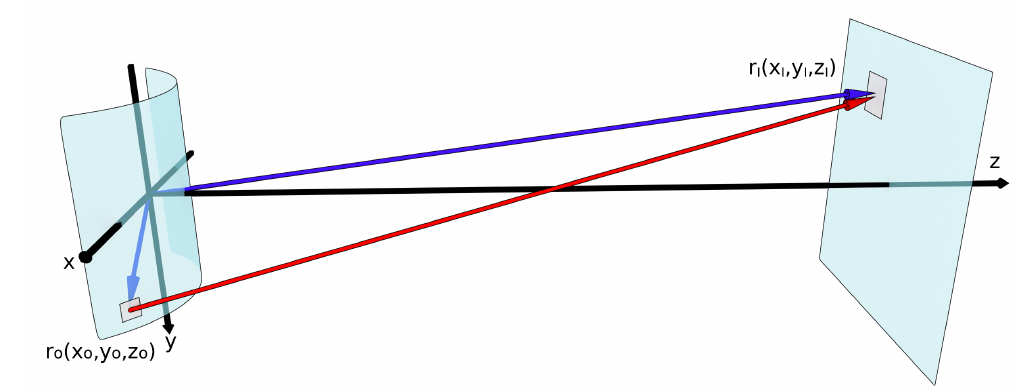
Figure 1. Light propagation from r O ( x O , y O , z O ) to r I ( x I , y I , z I ) using the Rayleigh–Sommerfeld equation. The holographic image originates from the metasurface (MS) and is projected onto the